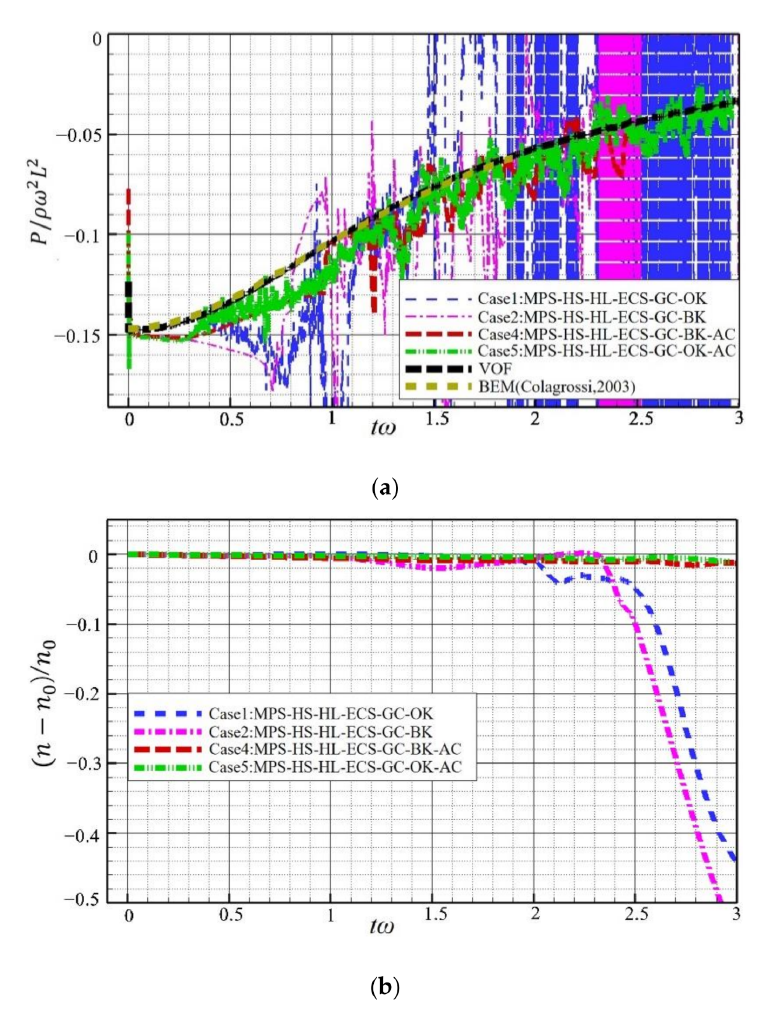
Figure 2. Time histories of the pressure and particle number density of a particle initially located at the center of the square fluid patch in the 2D case: ( a ) pressure; ( b ) particle number density.